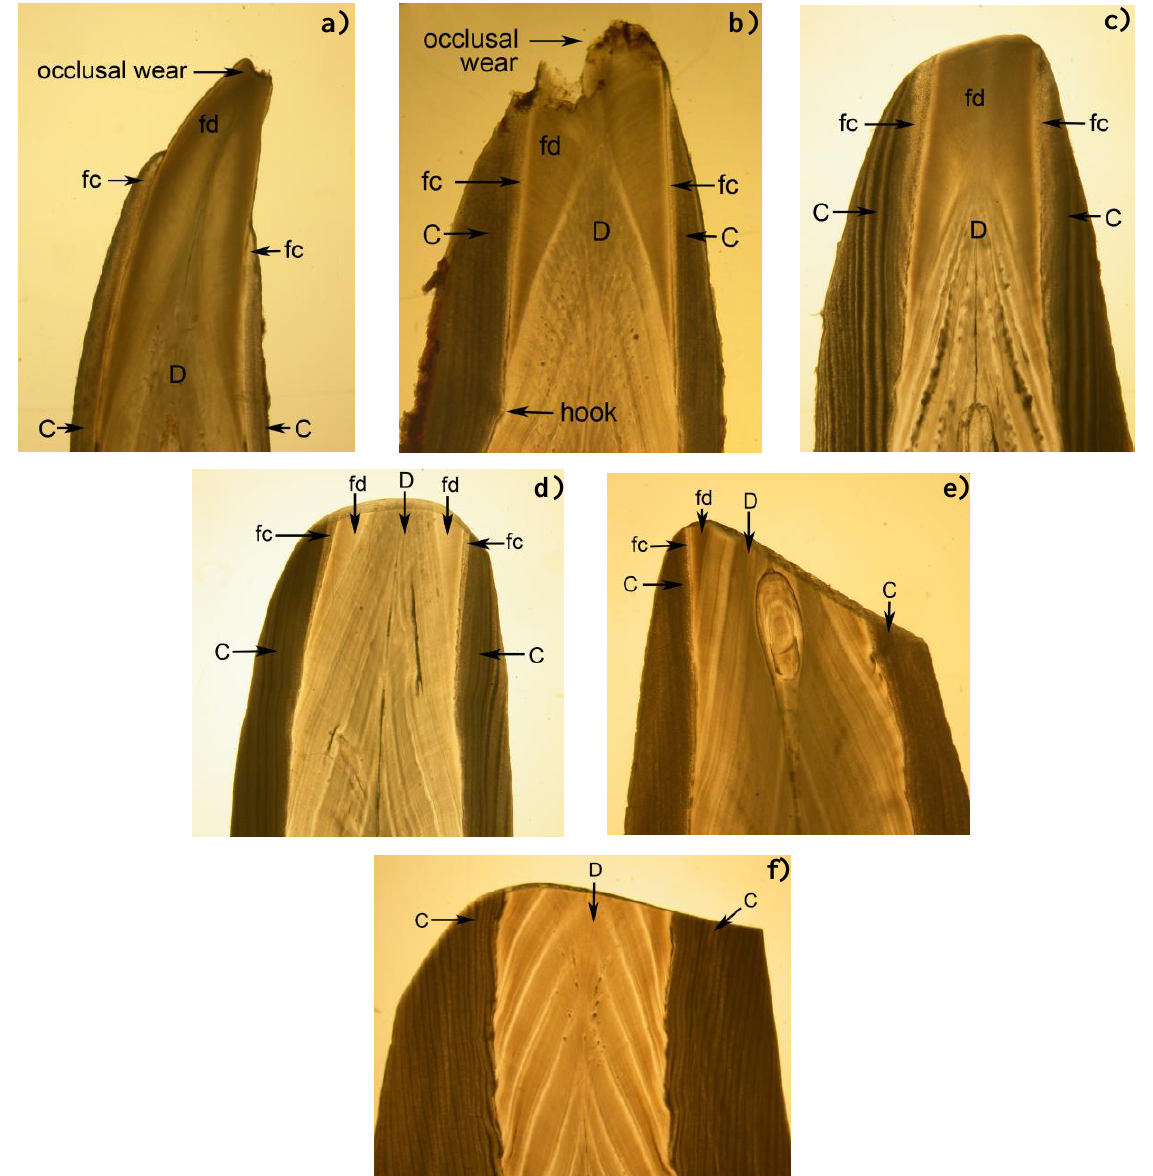
Fig. 7. As occlusal wear progresses, the arms of the fetal dentine eventually become separated and then fetal dentine may be eroded altogether. fd = fetal dentine; fc = fetal cementum; D = dentine; C = cementum. a) SP05-02, MNR-2. The slightly worn cusp is characteristic of occlusal wear on newly erupted teeth. b) PAU04-12, MNR-5. The fetal dentine is rough and irregular at the cusp. c) ARRB01-1103, MNR-5. The distal cusp has been worn smooth but the body and arms of the fetal dentine are still intact. d) ARGF-xx-1060, MNR-5. Significant occlusal wear has removed the cusp and body of the fetal dentine resulting in the separation of the fetal dentine arms; one arm is apparent on each side of the thin section. e) PAUL95-8, MNR-5. The cusp of the tooth has been worn on a significant angle. Only a remnant of one fetal dentine arm remains on the left side of the section. f) B97-166, MNR-5. Occlusal wear has eroded all of the fetal dentine; the age estimate generated from this thin section would be considered a minimum